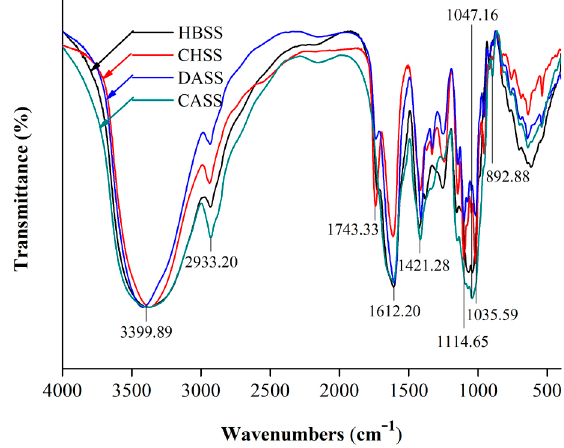
Figure 3. Fourier transform infrared (FTIR) spectrometric analysis of individual MLPs within the frequency range of 4000–400 cm − 1 .